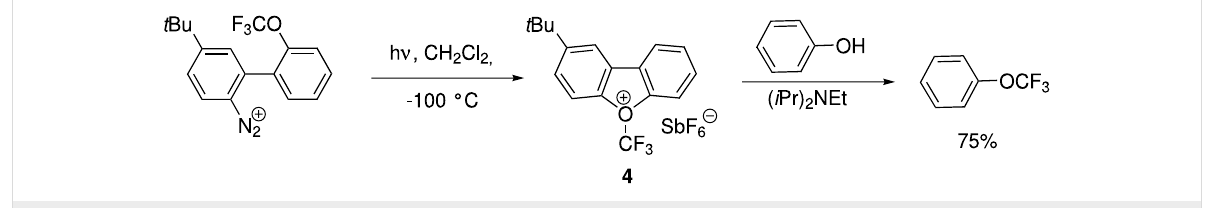
Scheme 7: Umemoto's O -(trifluoromethyl)dibenzofuranium salts 4 as CF 3 -transfer